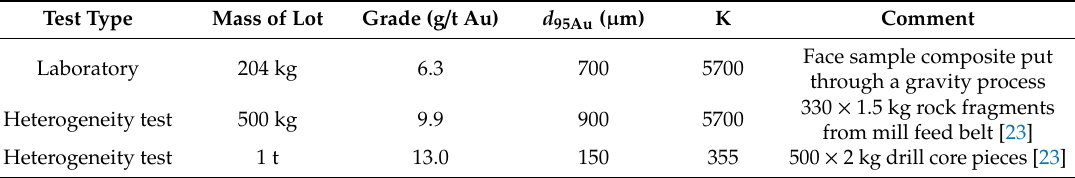
Table 5. Summary of d 95Au values determined from various methods.